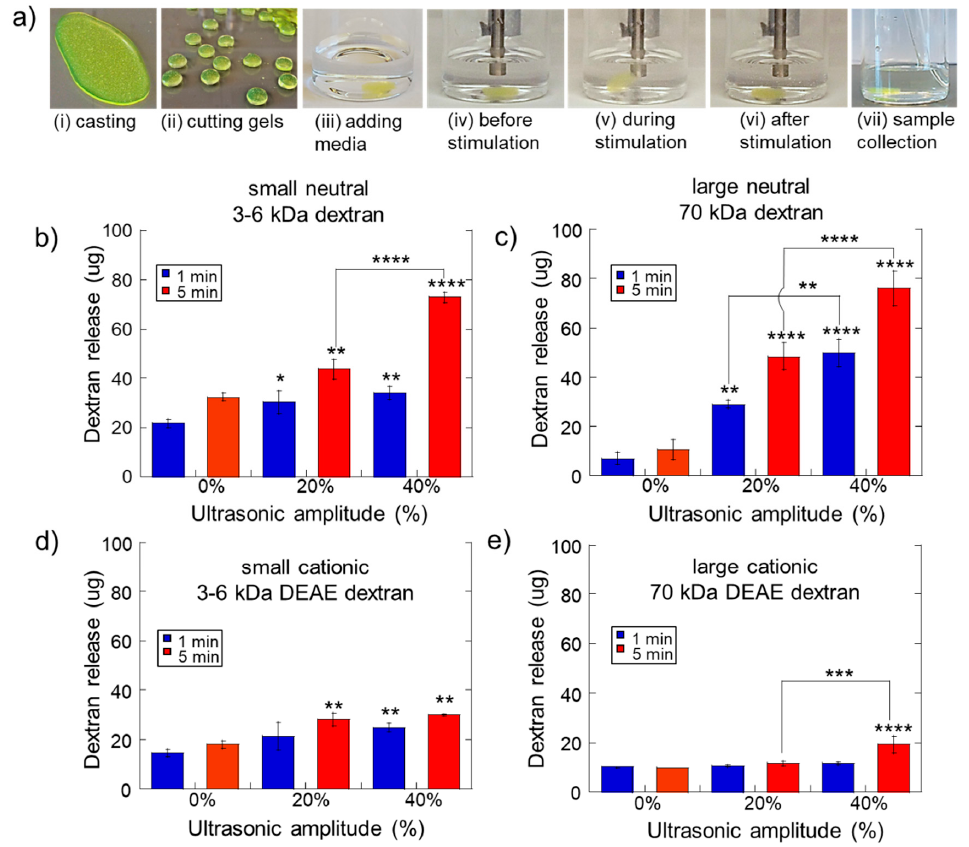
Figure 1. Ultrasonic amplitude, ultrasonic duration, molecular size, and molecular charge